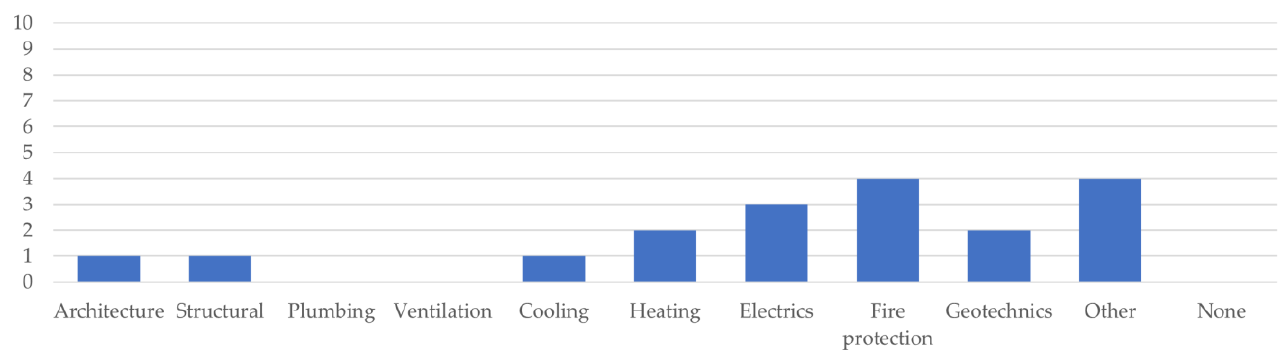
Figure 5. Responses to the question: “What disciplines were remodeled from CAD to BIM by your team?”.